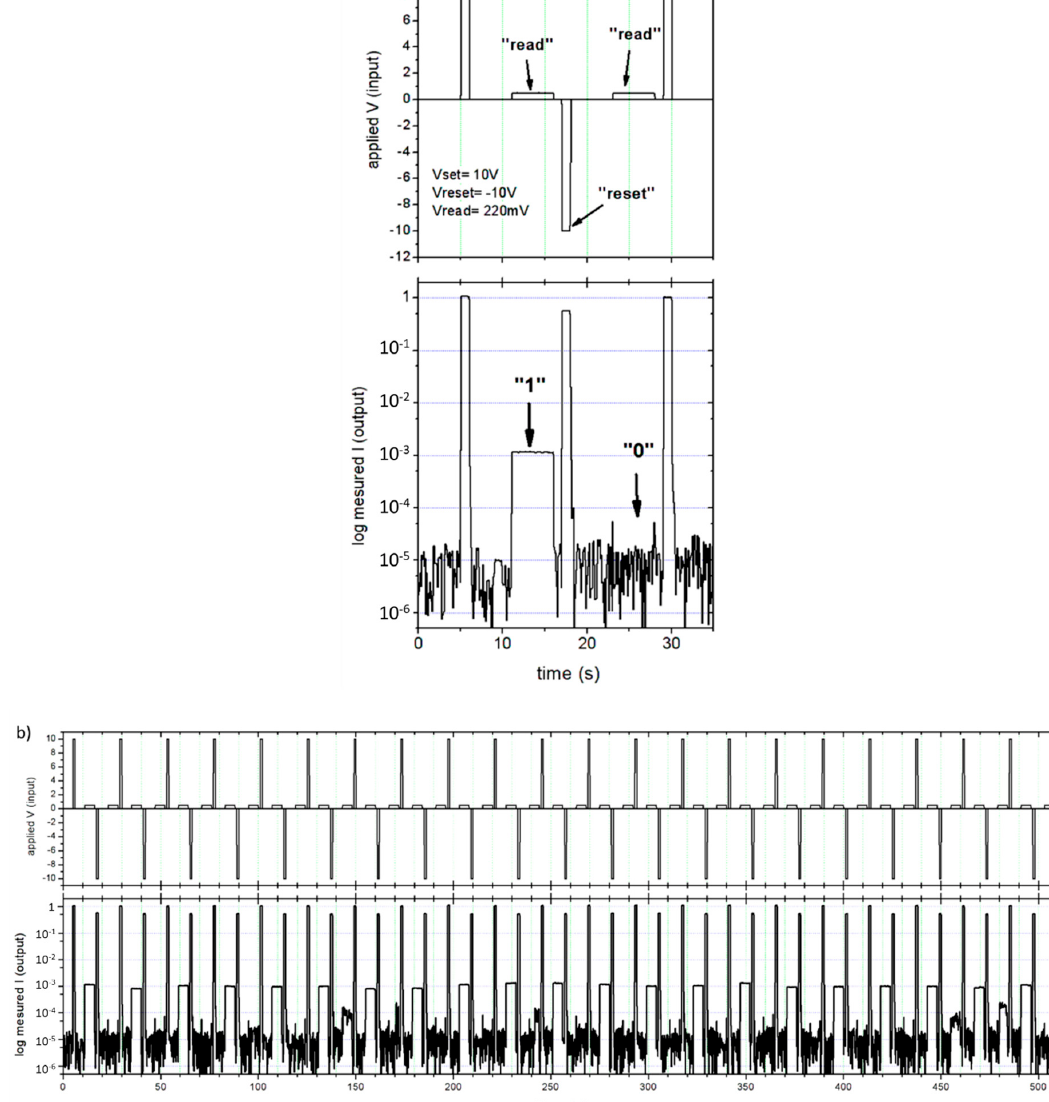
Figure 6. ( a ) Description of the read/write operation of a wetOxPSi memristor. ( b ) Successive read/write operations on a wetOxPSi ReRAM cell. operations on a wetOxPSi ReRAM